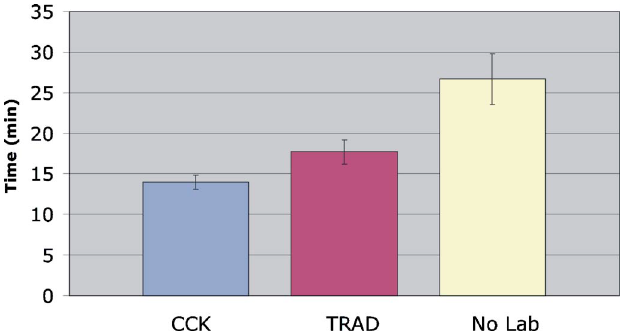
FIG. 3. (cid:1) Color (cid:2) Timing data showing how long it took students to build a real circuit and write up what happened. Students had previously conducted a laboratory using simulated (cid:1) CCK (cid:2) or real equipment (cid:1) TRAD (cid:2) , or had not conducted a laboratory (cid:1) No Lab (cid:2) . CCK and TRAD students are in an algebra-based course, the No Lab students are enrolled in a calculus-based course. Error bars indicate standard error of the mean for each condition.